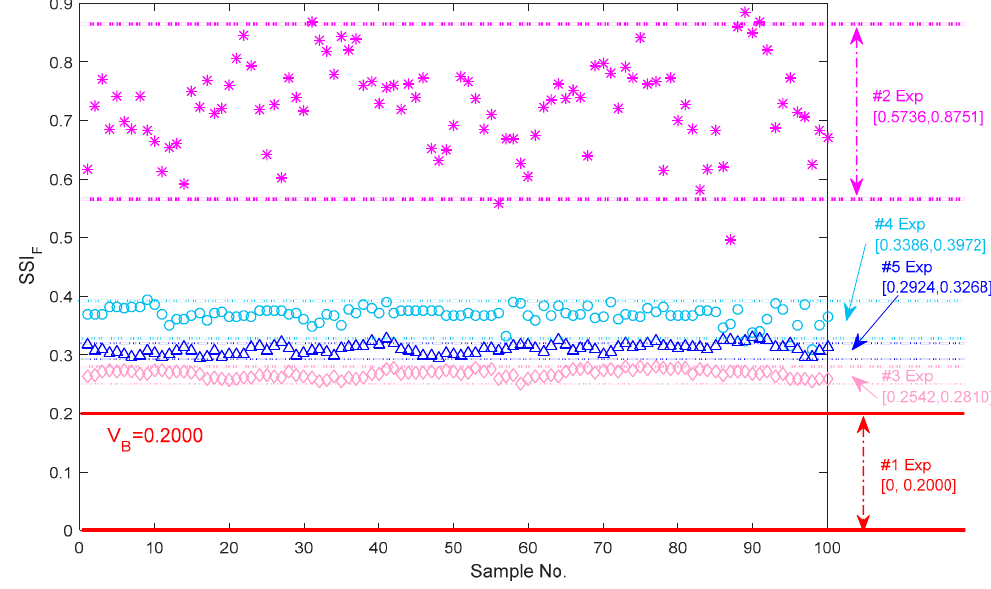
Figure 12. Upper and lower boundaries of SSI F for quantification of bearing vibration signals with the different faults.